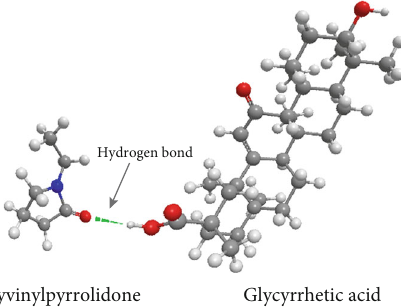
Figure 6: The schematic diagram of the intermolecular hydrogen bond between GA and